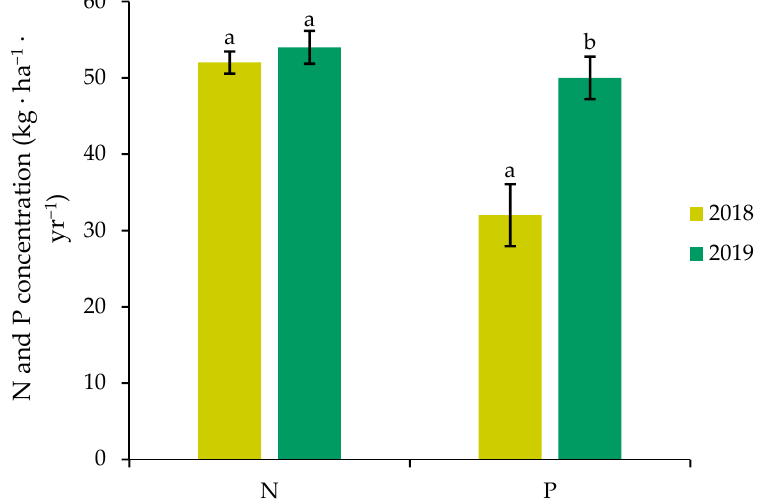
Figure 4. Total N and P concentrations in willow plants for two years once exposed to WW irrigation in the field (mean ± SE). N and P concentrations were analyzed using ANCOVA for years. Different small letters represent the significant difference between years at p < 0.05 using Tukey’s HSD test.